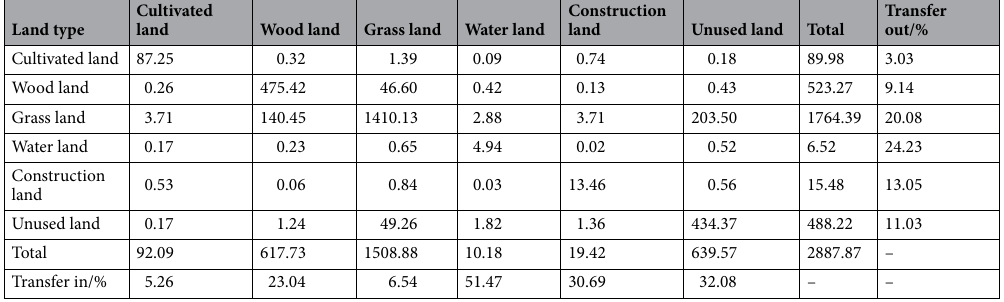
Table 3. 2018–2020 Land use area transfer matrix (km 2